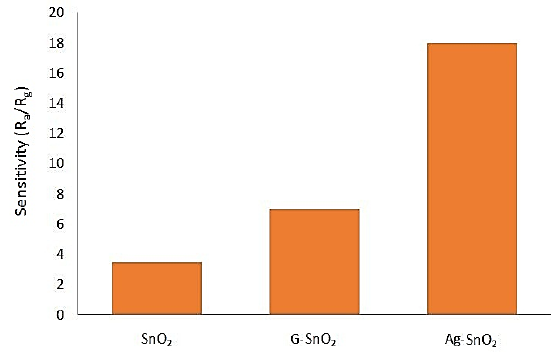
Figure 14. Sensitivity Comparison among SnO 2 , G-SnO 2 and Ag-SnO 2 .